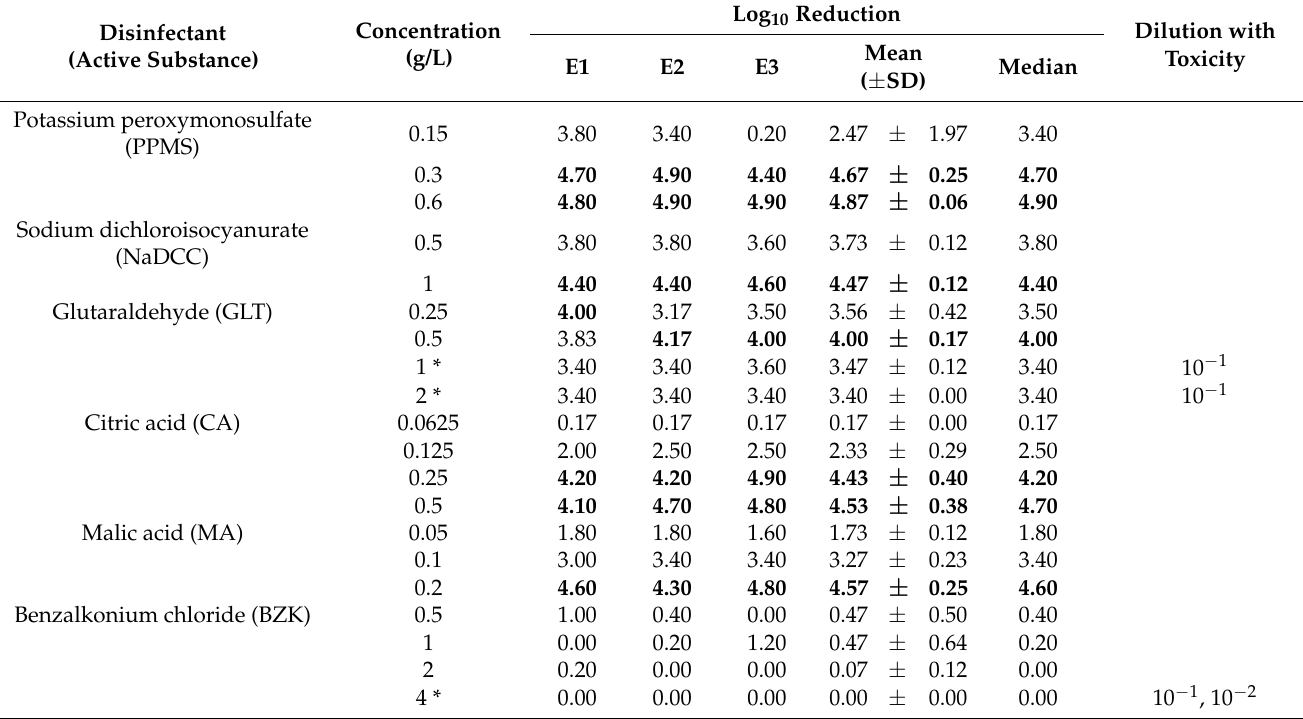
Table 1. Virucidal activity of active substances against foot-and-mouth disease virus.